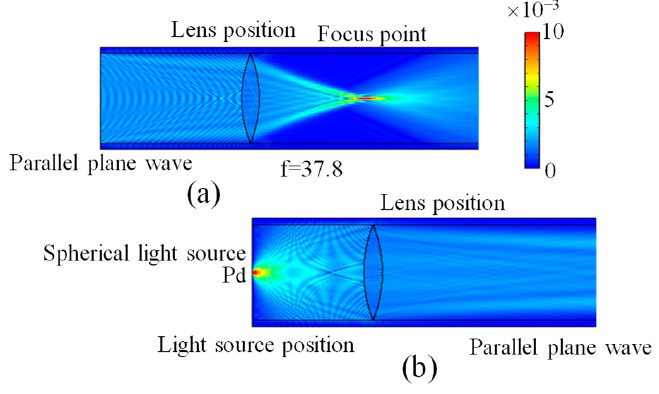
Figure 3. Focus length of the optical model. ( a ) Checking the focal point in the case of collimated light incidence. ( b ) Confirmation of collimated light at the focal point light source.